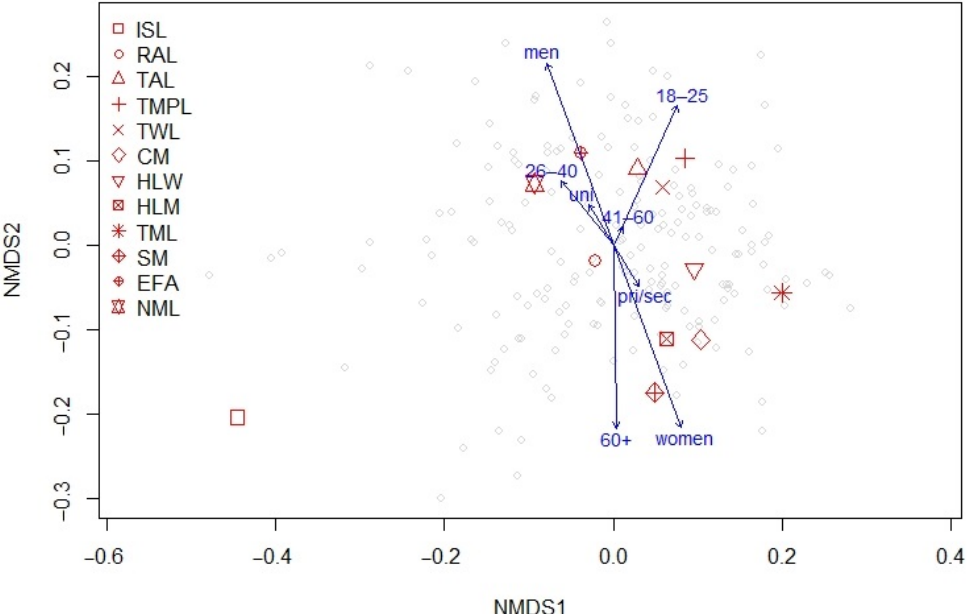
10 of 17 Figure 8. Which types of landscape do you find the most endangered/degraded? (Legend: